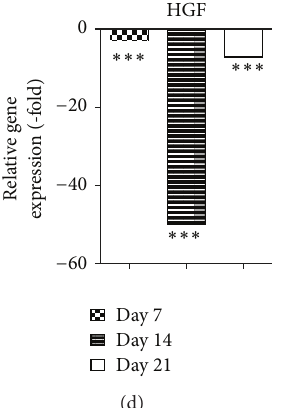
Figure 3: Osteogenic differentiation of ASCs increases expression of anti-inflammatory cytokines. ASCs were grown in CCM and then changed to ODM. After 7, 14, and 21 days, cells were harvested and analyzed by qRT-PCR. Data is normalized to undifferentiated cells. Mean ± SEM. ∗ 𝑃 < 0.05 ; ∗∗ 𝑃 < 0.01 ; ∗∗∗ 𝑃 < 0.001 relative to undifferentiated